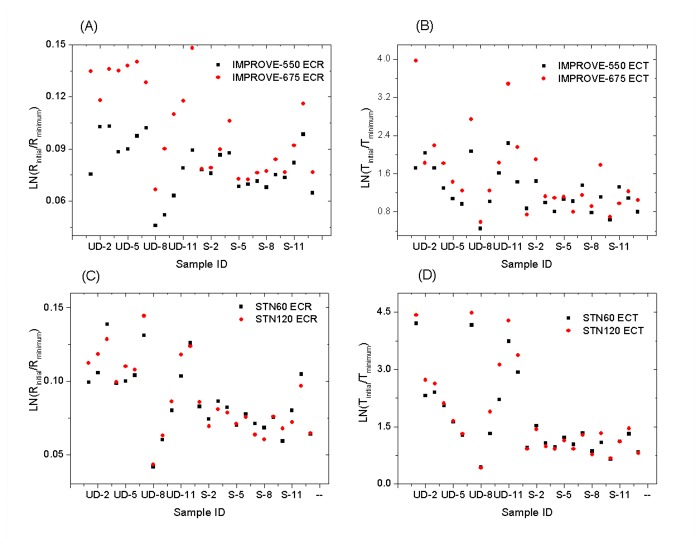
Laser signal changes, i.e., ∆Rmin and ∆Tmin (the minimum R and T minus the corresponding initial R and T) among the four different protocols (IMPROVE-550 vs. IMPROVE-675 in (A)-(B) and STN60 vs. STN120 in (C)-(D)), which serve as indicators for the degree of pyrolysis.UD stands for urban dust and S stands for soil. See supplement Figure S1 and Table S1 for sample IDs.